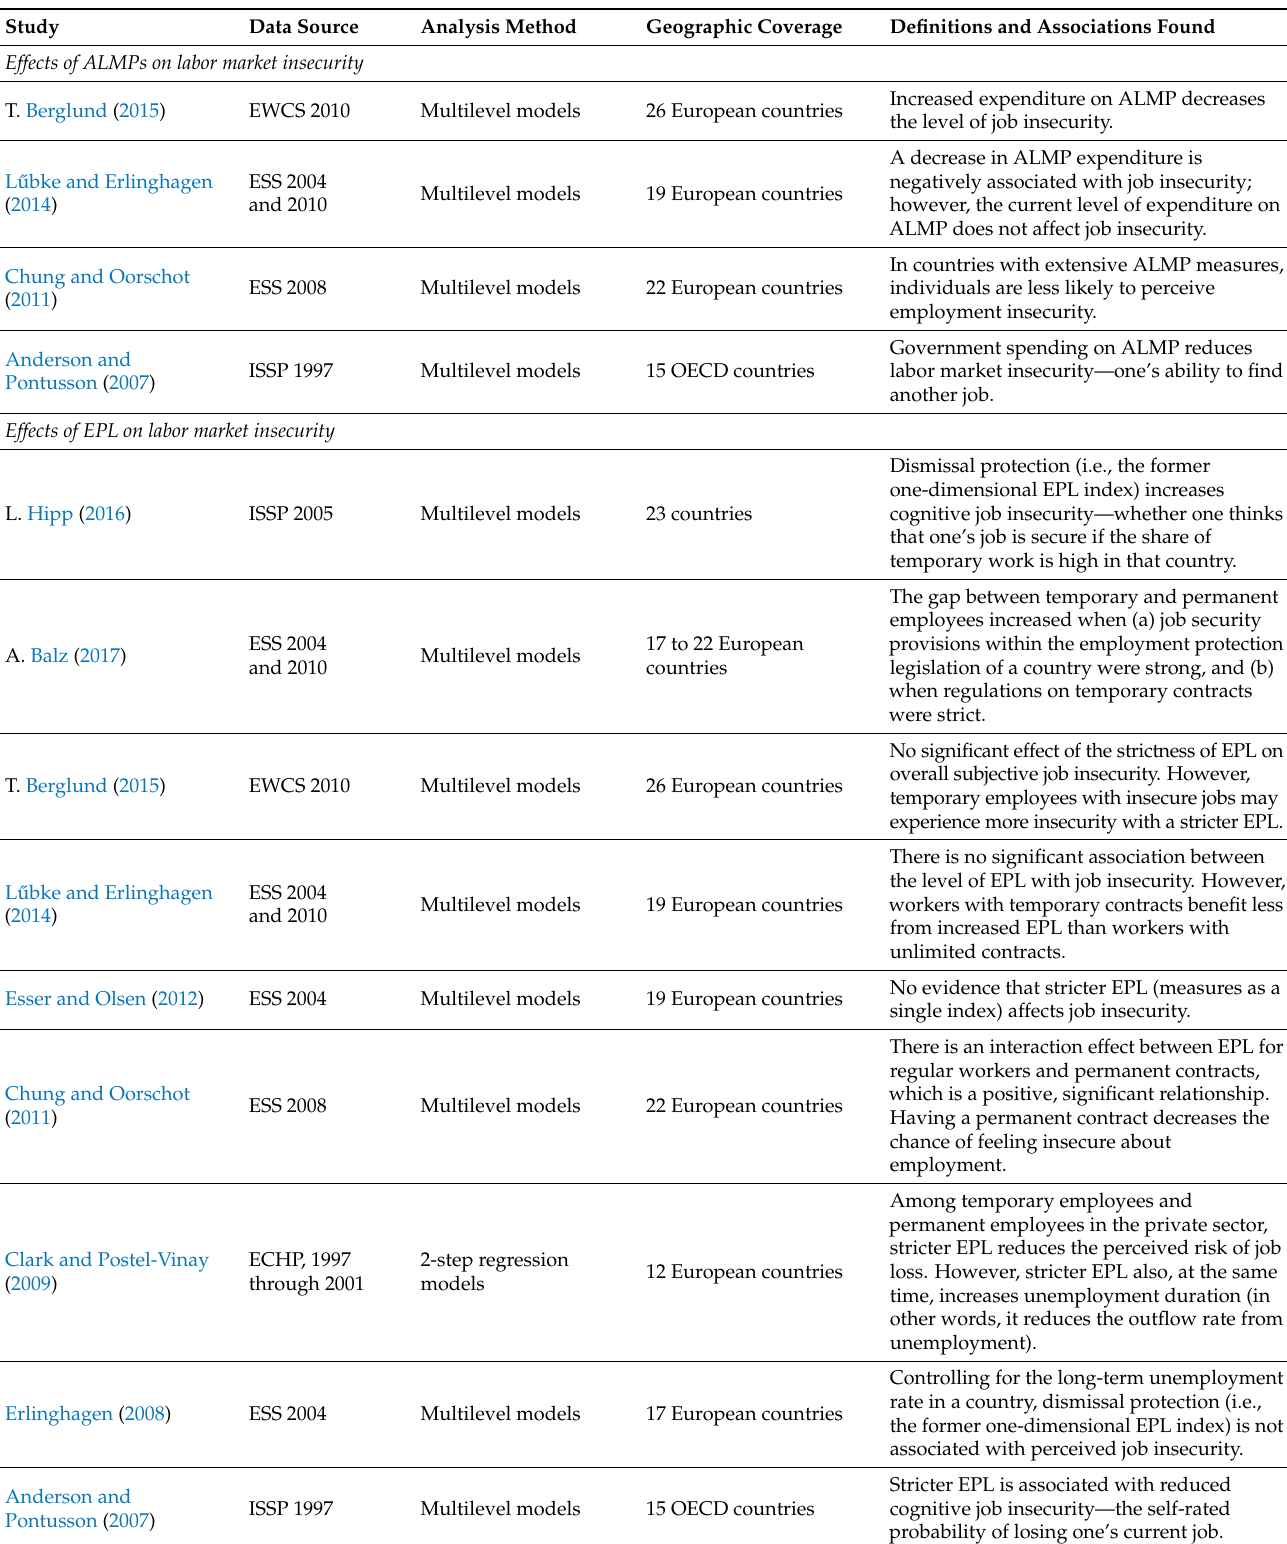
Table A1. Summary of the cross-national literature on institutional factors, labor market insecurity, and